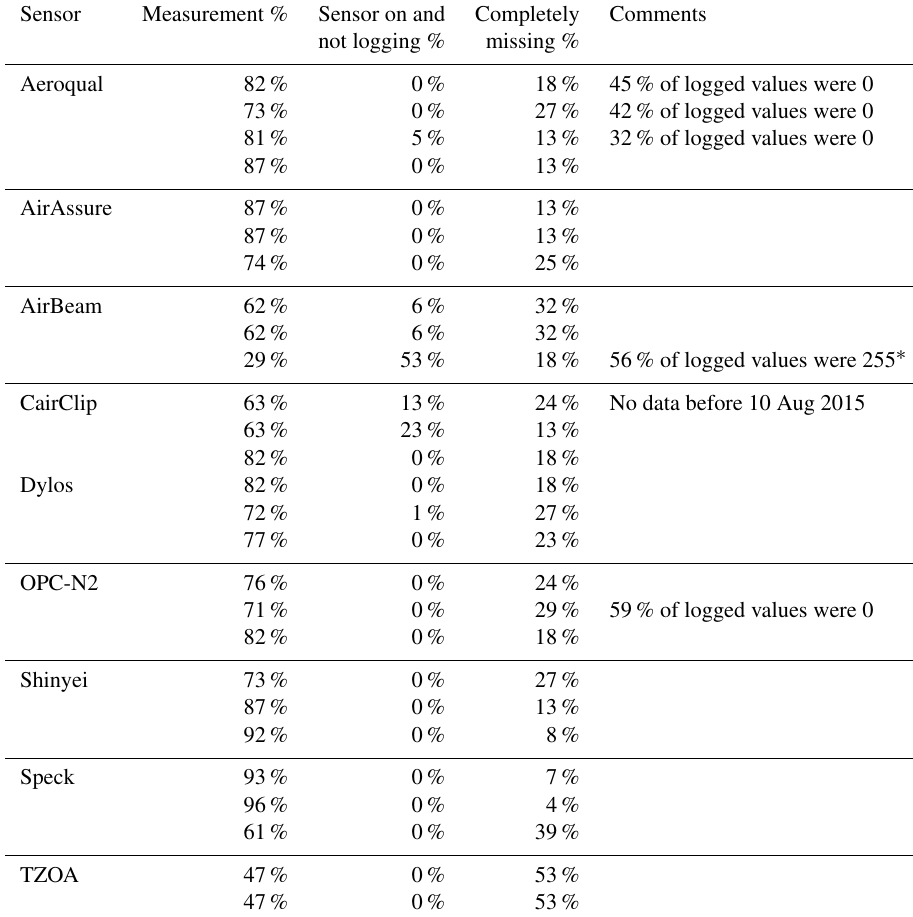
Table 2. Sensor data completeness. Sensor Measurement % Sensor on and